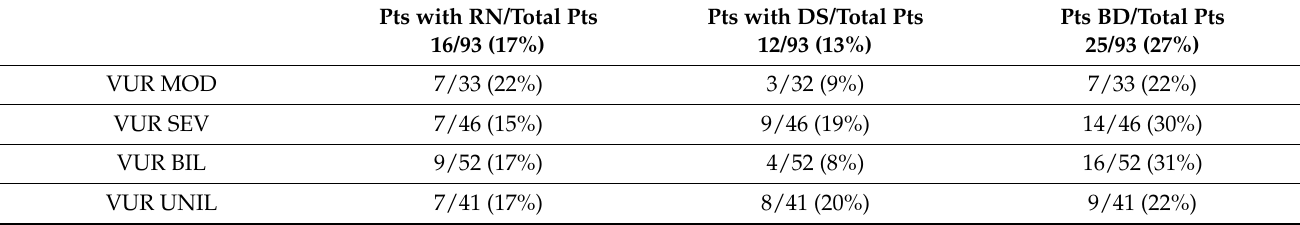
Table 2. Distribution of VUR according to grade and laterality in different groups of patients with RN, DS and BD.